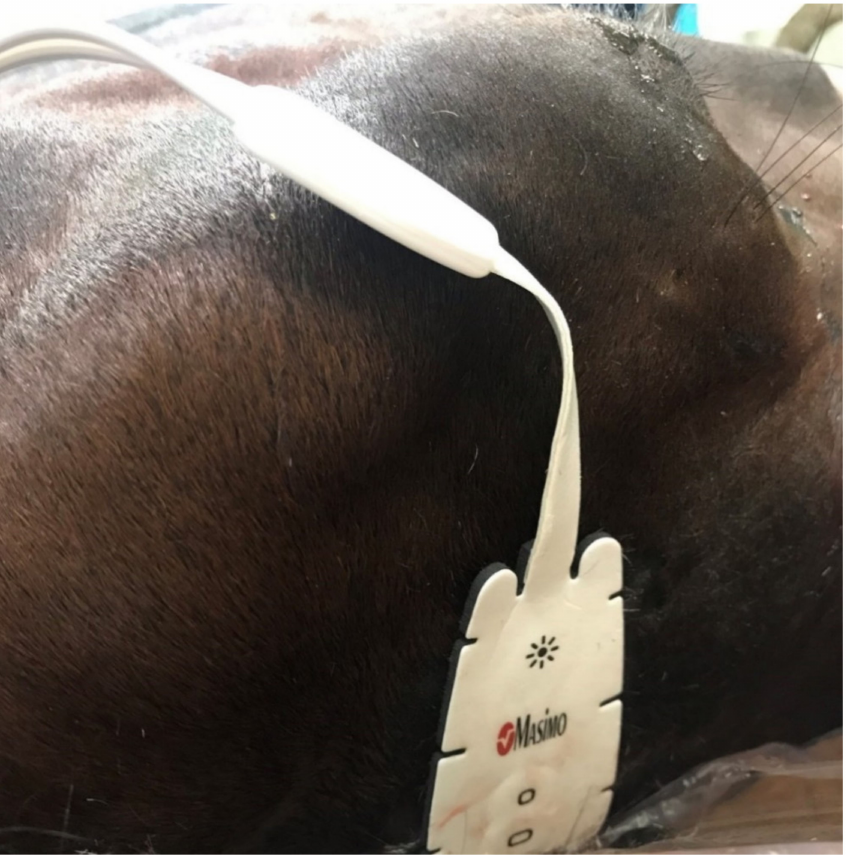
Figure 2. Sensor for measuring oxygenation of cerebral blood using the NIRS method (by Masimo ® , Irvine, CA, USA), located above the dorsal sagittal sinus, which is a pool of venous blood from the cerebral hemispheres (horse is in the lateral